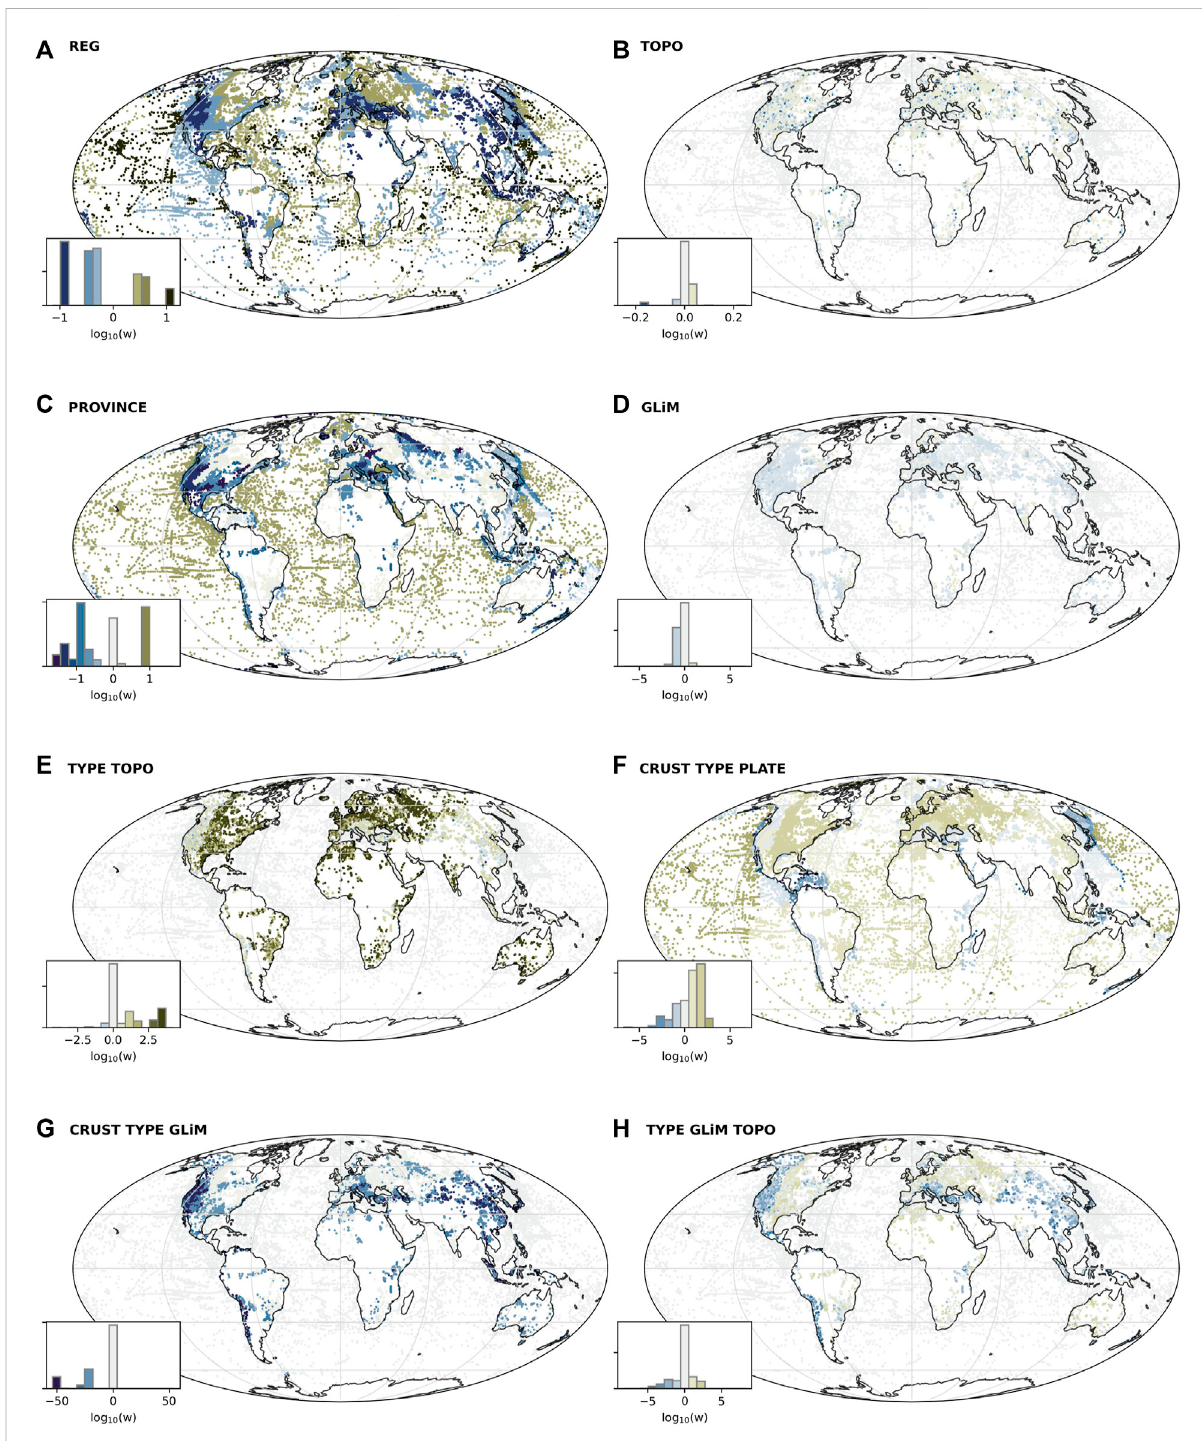
FIGURE 4 Calculated weights for selected categorical variables and suggestions for combined weights. (A) REG (Schaeffer and Lebedev, 2015) (B) Geomorphological forms (Amatulli et al., 2020) (C) Province (Hasterok et al., 2022) (D) GLiM (Hartmann and Moosdorf, 2012) (E) IPF calculated joint weighting from TYPE and TOPO, (F) IPF calculated joint weighting from CRUST, TYPE, and PLATE, (G) IPF calculated joint weighting from TYPE and GLiM, (H) IPF calculated joint weighting from TYPE, GLiM, and TOPO. The weights are displayed as a logarithmic colour representation to allow for the ranges to be compared. Measurements with no weighting (i.e. weight of 1) are shown in grey, those that are weighted down are in blue, and measurements weighted up are shown in brown. The inset histogram shows the relative log – value distribution. Note that the scale differs for each subplot for